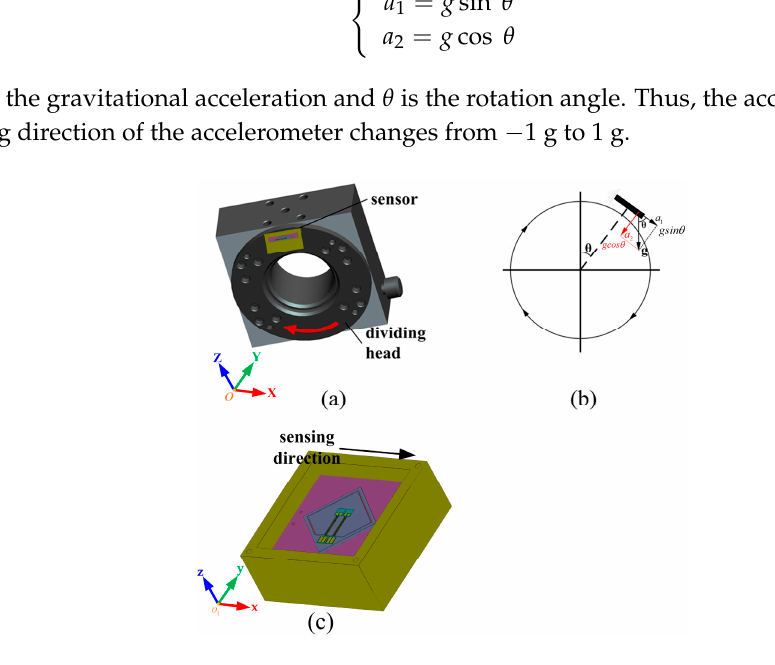
Figure 17. Schematic diagram of tumbling experiment: ( a ) structure of the dividing head and the sensor assembly; ( b ) changing process of acceleration along the sensor’s sensing direction; and ( c ) schematic diagram of the testing sensor.